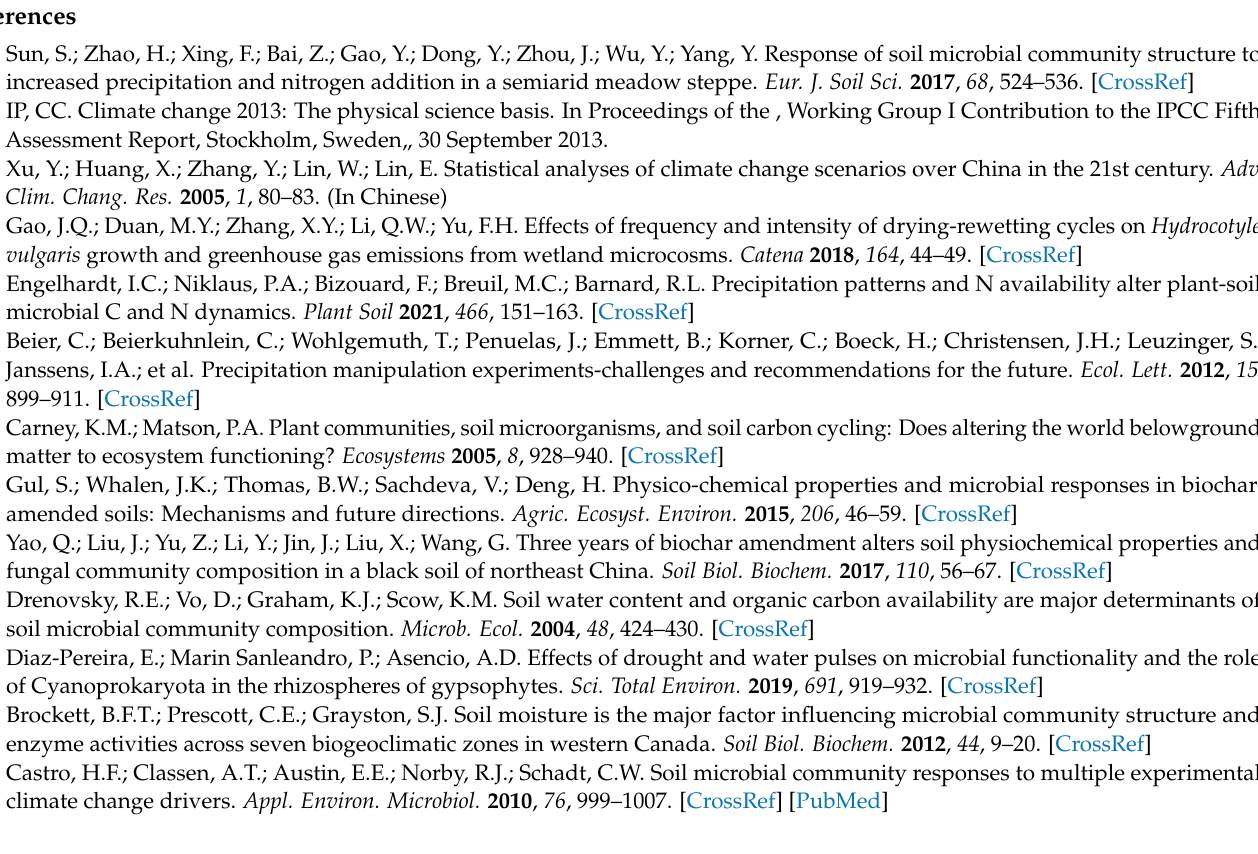
Figure S5: Significance test of bacterial function prediction (hierarchy level